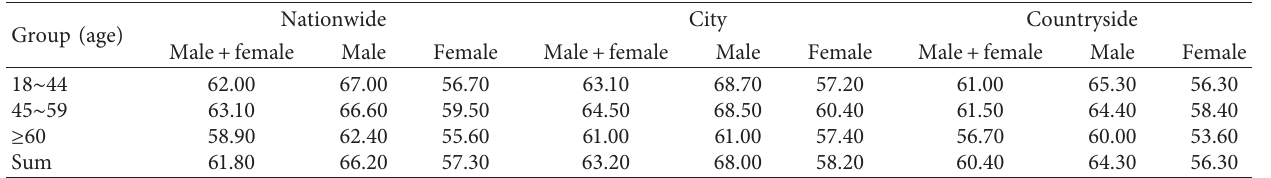
Table 2: Average weight of Chinese residents (kg).